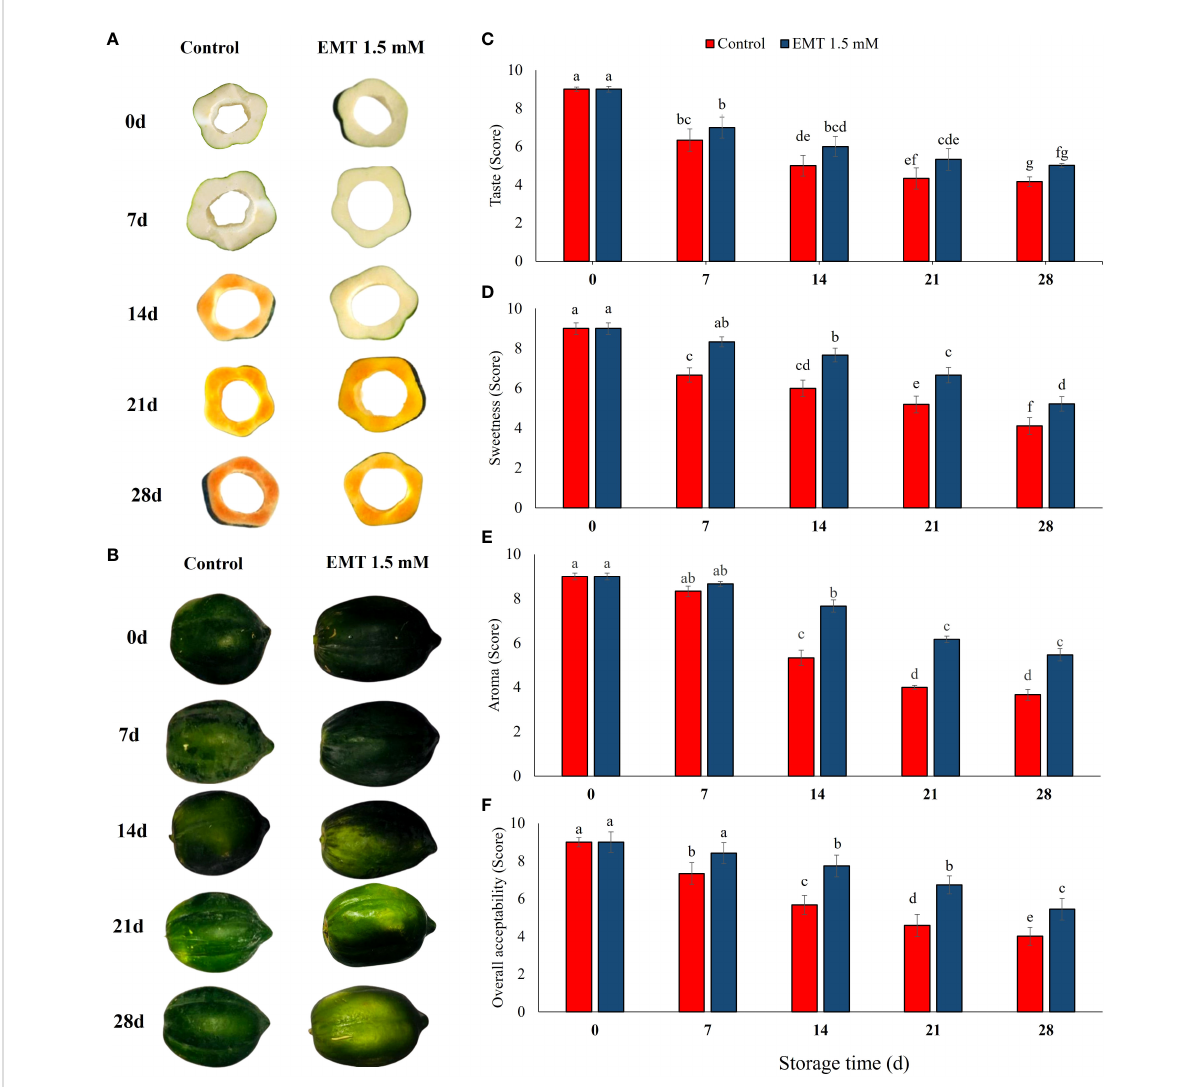
FIGURE 7 Effect of EMT treatment on visual quality (A, B) , taste (C) , sweetness (D) , aroma (E) , and overall acceptability (F) of papaya fruits during cold storage. Data collected from the mean of three replicates, and vertical bars indicate the standard error of the means. Mean values with different letters show signi fi cant differences, and those with the same letters show no statistical difference according to the least signi fi cant difference test (P <